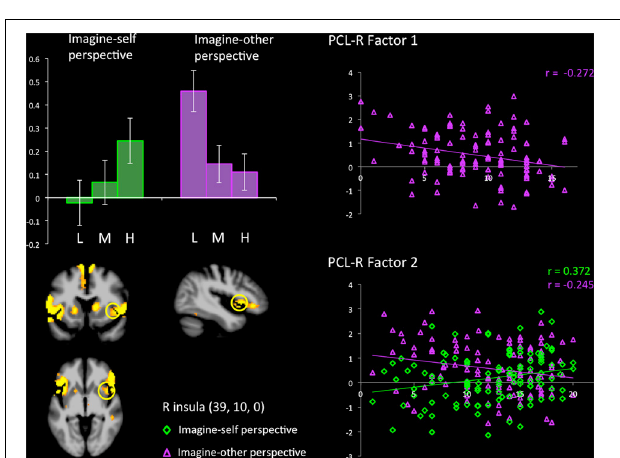
FIGURE 4 | Functional connectivity analyses, seeded in the anterior insula in participants with the lowest scores on the PCL-R ( ≤ 20) and participants with the highest scores on the PCL-R ( ≥ 30) during imagine-self